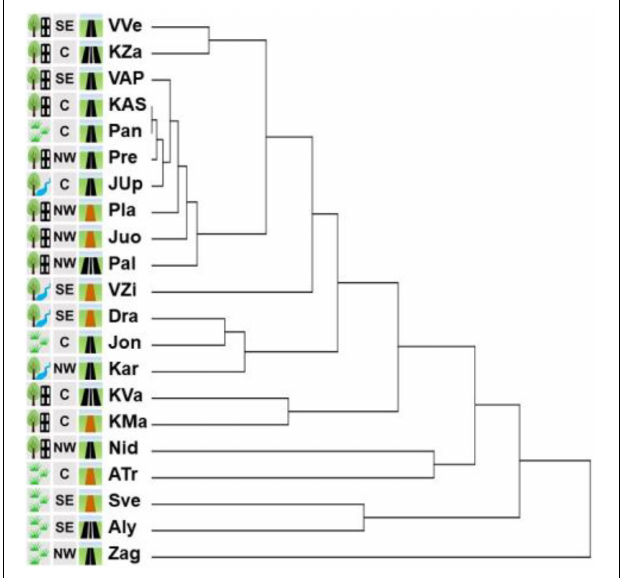
FIGURE 9 | Cluster analysis of the similarity of the assemblages of herbaceous plant species in 21 sites with Impatiens parviflora . Three letters denote populations (location is provided in the Figure 1 . Pictogram explanations are provided in the Table 1 ).